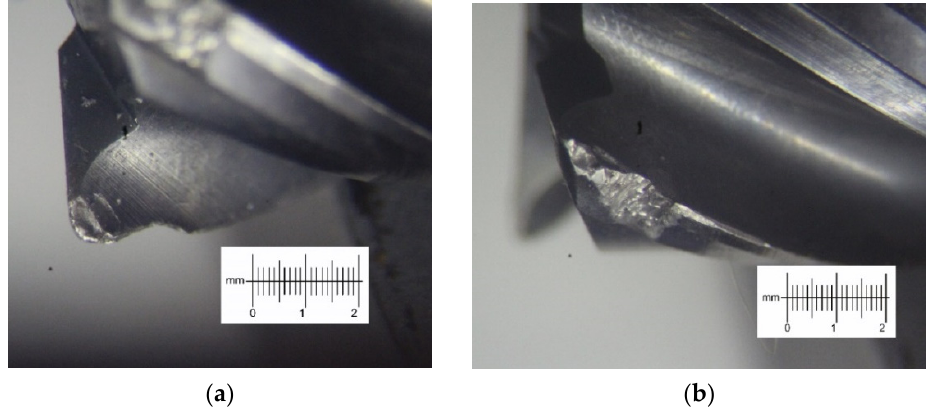
Figure 13. Photo of the wear of cutter No. 2 on the rake ( a ) and flank ( b ) surface.